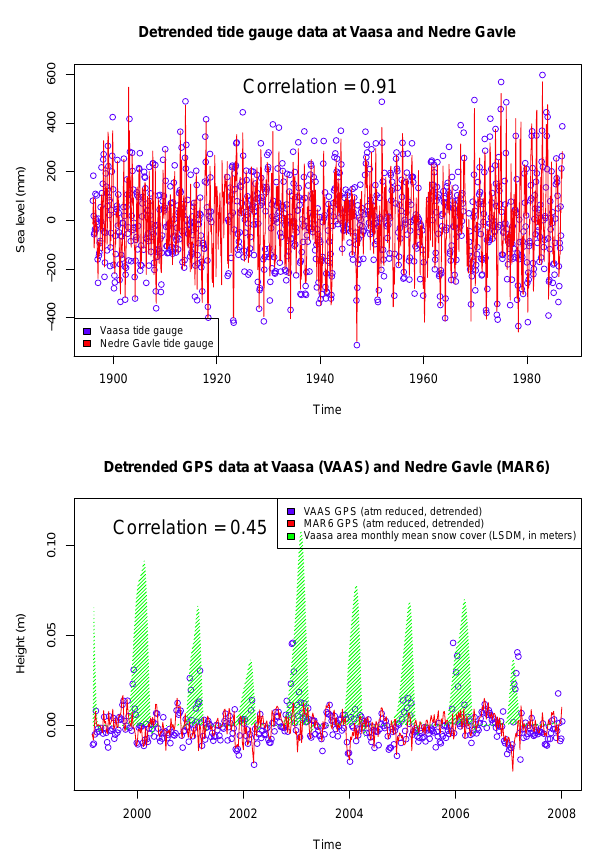
Fig. 9. The upper panel: the detrended sea level time series for Fig. 8. The upper panel shows the detrended tide gauge time series for Vaasa and Nedre Gavle for the common period (1896-1986). The tide gauges Vaasa and Nedre Gavle for the common period (1896– correlationbetweenthetwoisveryhighat R 2 > 0 . 9 . ThelowerpanelshowsthedetrendedGPStimeseriesfortheco-located stations. The correlationisloweredsignificantly( R 2 =0 . 45 )bytheerrorscausedthroughsnowcoverontheantennaatVAASstation. Thegreenshading 1986). The lower panel: the detrended height time series for the depictsthemodeledmeansnowcover(inmeters)atthefourneighboringgridpointssurroundingthestationintheLSDMhydrologymodel. co-located GPS stations Vaasa (VAAS) and Nedre Gavle (MAR6). The green shading depicts the modelled mean snow cover at the four neighbouring grid points surrounding the station according to the LSDM hydrology model.